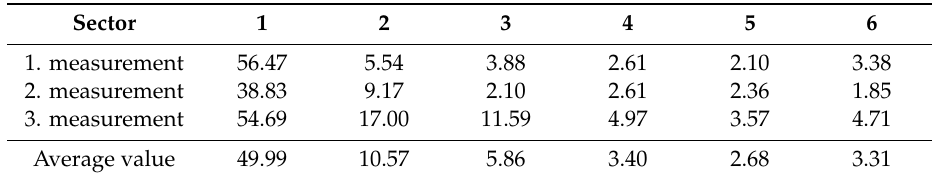
Table 2. Second set of measurements of oil film areal density (g / m 2 )—a slim tube with the inner diameter of 25 mm .